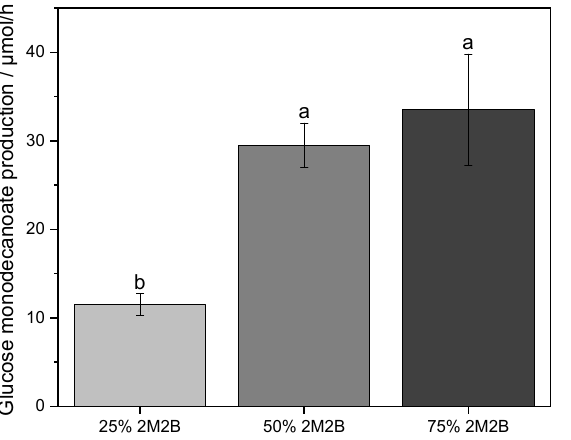
Figure 3. Influence of relative flow rates of glucose and fatty acid feed on glucose monodecanoate production. a, b show statistically significant differences (one-way ANOVA, Tukey’s test, p < 0.05).